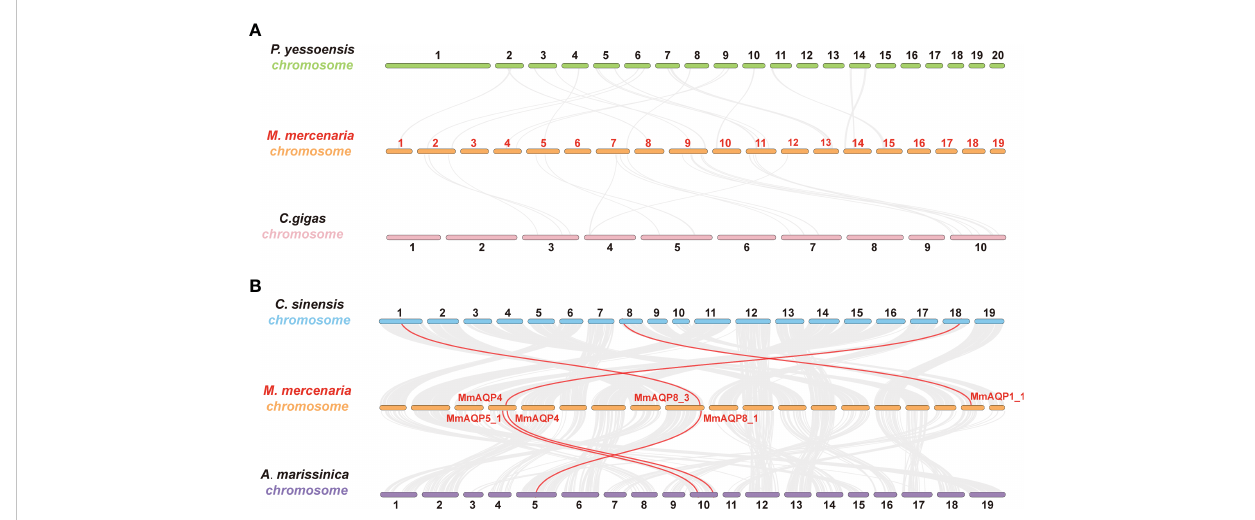
FIGURE 5 Synteny analysis to detect the orthologs of MmAQPs in the geome of P. yessoensis and C. gigas (A) , as well as C. sinensis and A. marissinica (B) . Grey lines in the background represent the collinear gene pairs between the two genomes. The orthologous AQP gene pairs are linked by red lines.